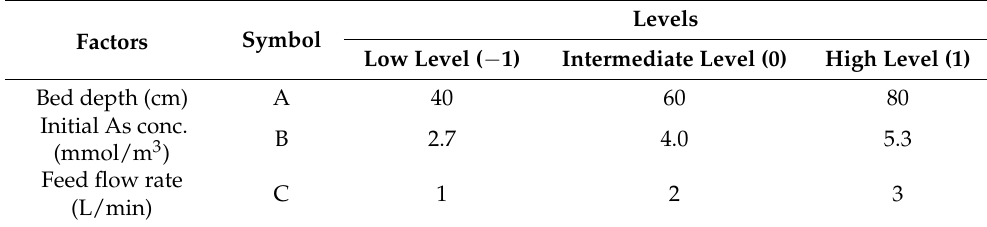
Table 3. Factors and their levels for